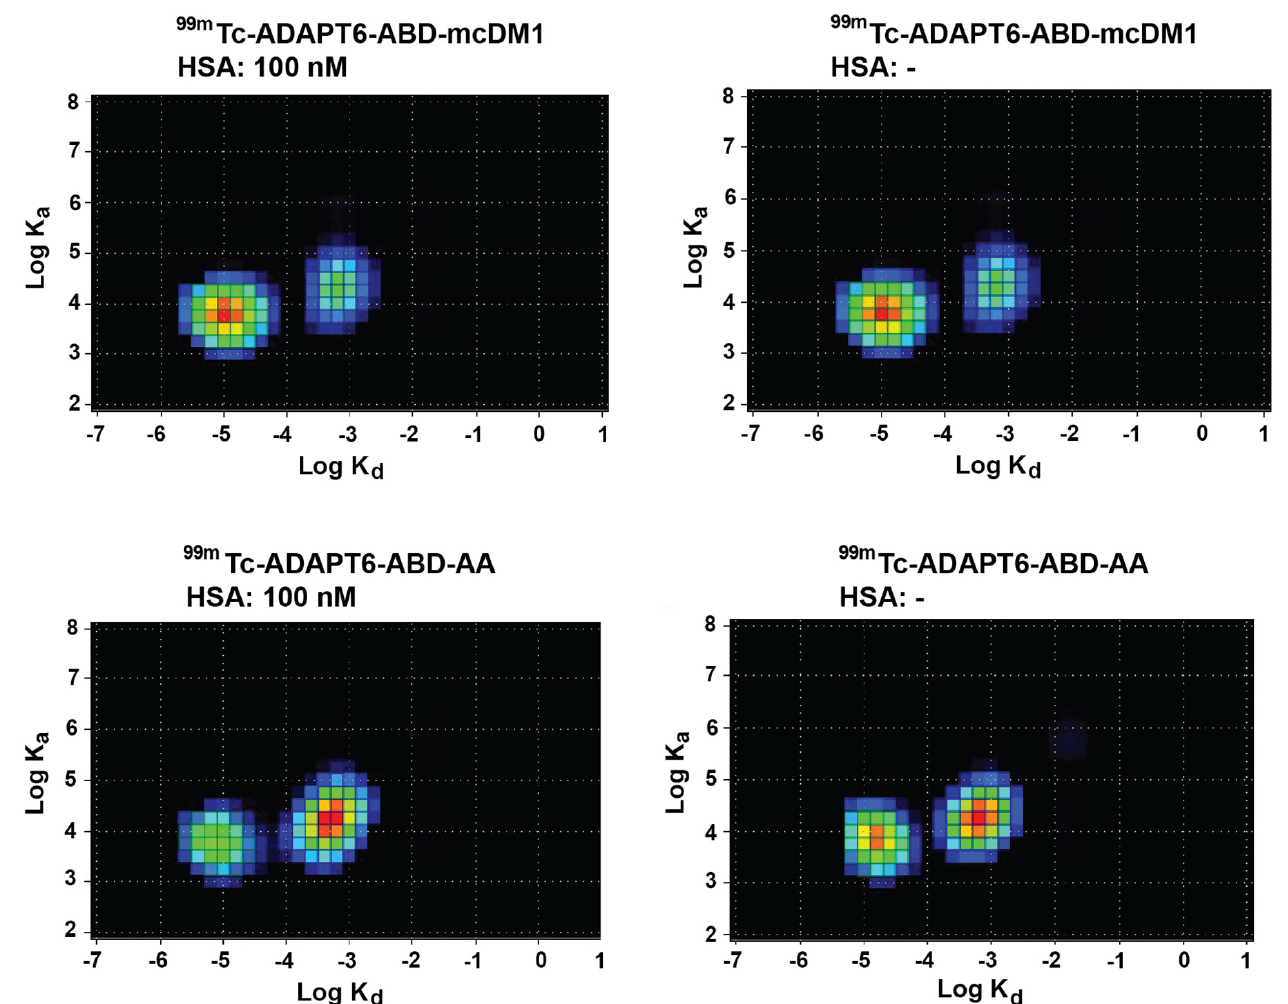
Figure 5. Interaction maps. The interaction of 99m Tc-ADAPT6-ABD-mcDM1 and 99m Tc-ADAPT6-ABD-AA with SKOV-3 cells was analyzed in a LigandTracer biosensor in the absence or presence of HSA (100 nM), and interaction maps were generated from the recorded data. The warmer colors in the map correspond to a larger degree of contribution to the interaction. The x-axes correspond to the logarithm of the dissociation rate (k d ) and the y-axes correspond to the logarithm of the association rate (k a ). The data demonstrate two interactions with similar association rates but with different dissociation rates.